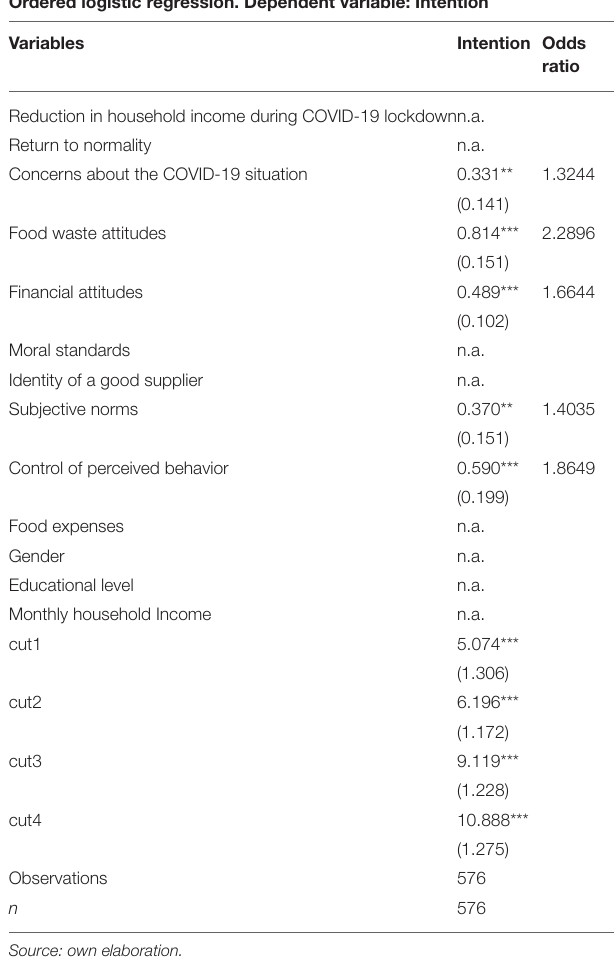
TABLE 4 | Ordered logistic regression for the variable intention to not waste food . Ordered logistic regression. Dependent variable: